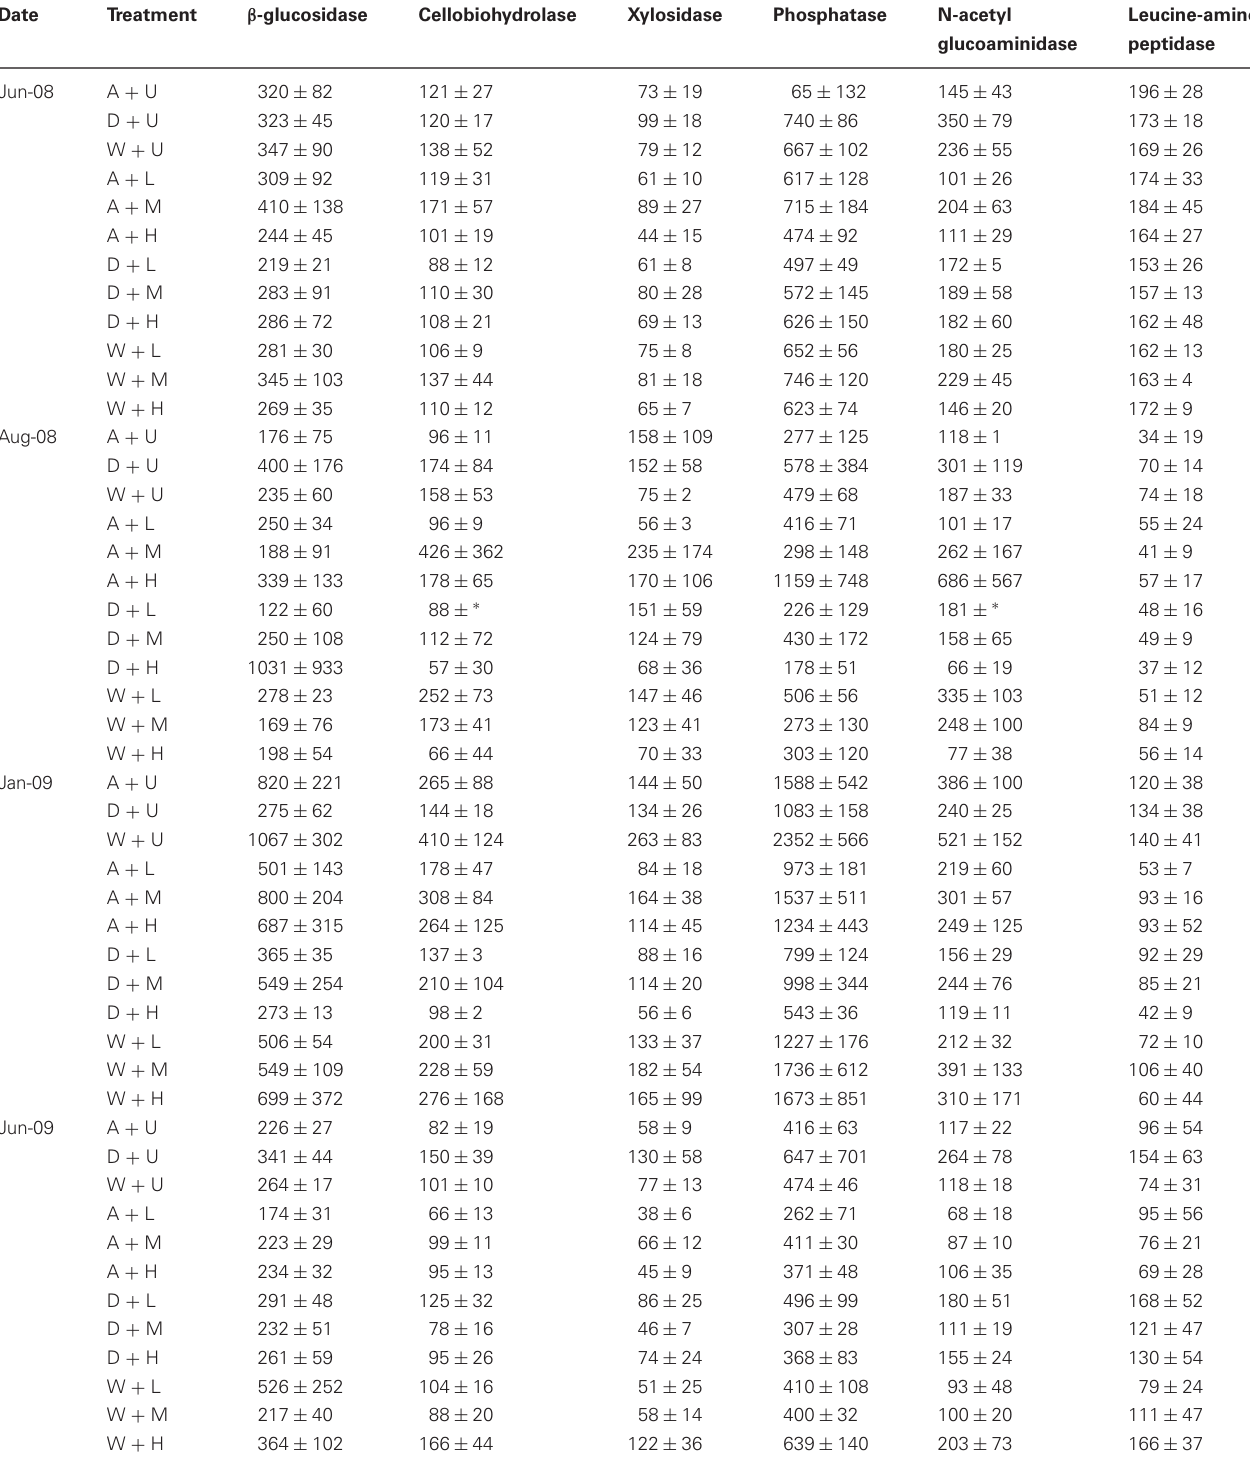
Table 2 | Potential enzyme activity in 0–5cm soils, mean ±